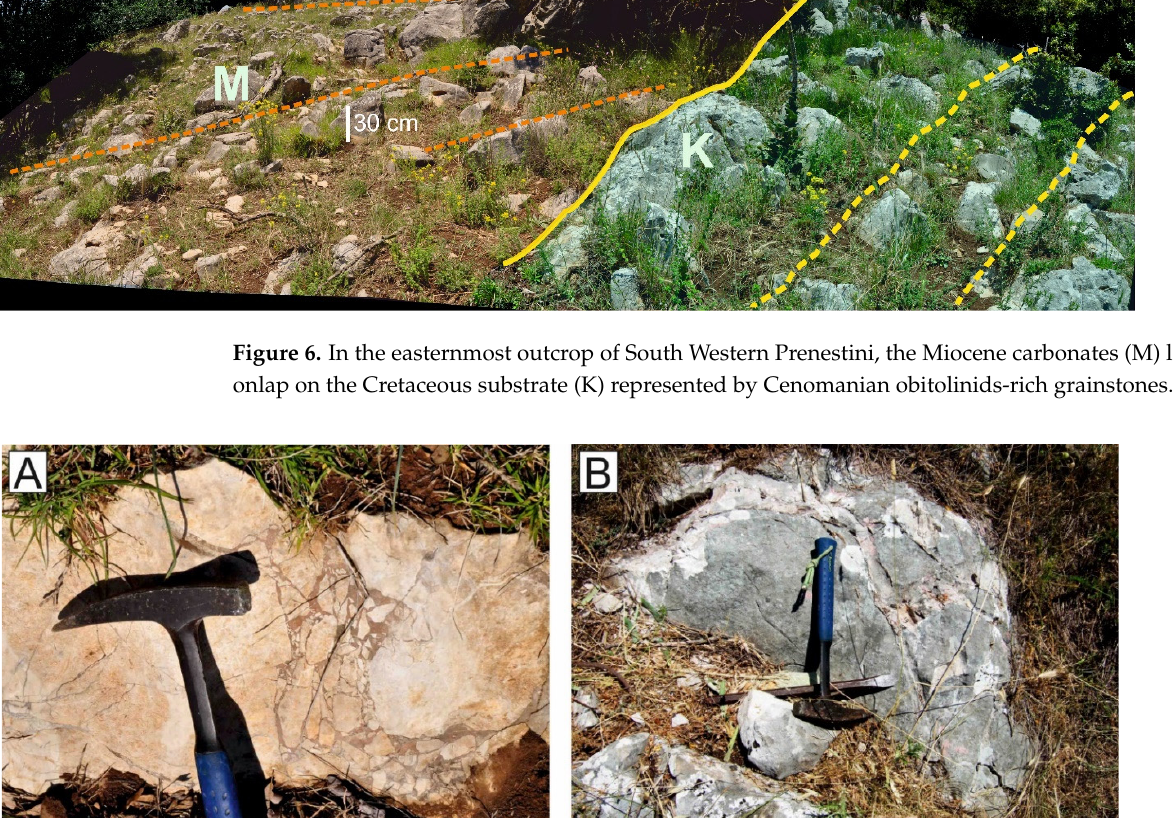
Figure 7. ( A ) The Cretaceous unconformity in the eastern sectors of South Western Prenestini (Colle Pompeo outcrop) shows karst features represented by breccias and red soil infilling fractures; ( B )